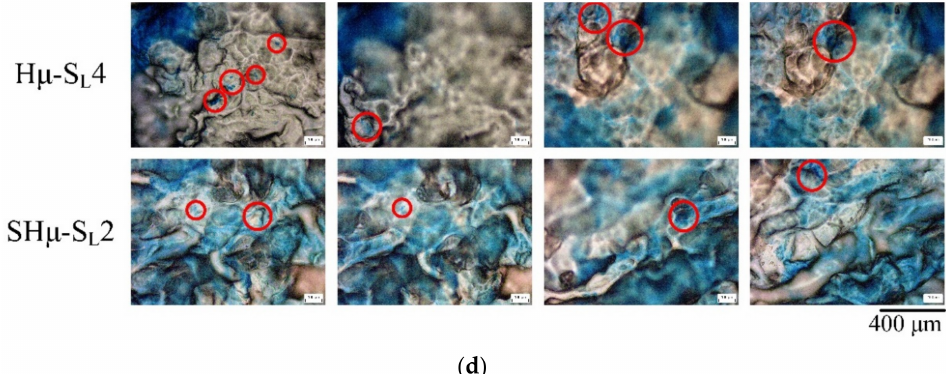
Figure 8. Hydrogel scaffolds used to culture chondrocytes at different times: ( a ) cell proliferation ( # indicates that the groups are not significantly different after comparison ( p > 0.05)), ( b ) scaffold appearance after Alcian blue staining, ( c ) cross-sectional OM images after Alcian blue staining, and ( d ) mineralization of H µ -SL4 and SH µ -SL2 cultured on the 28th day after Alcian blue staining (blue stain in a red circle represents bone